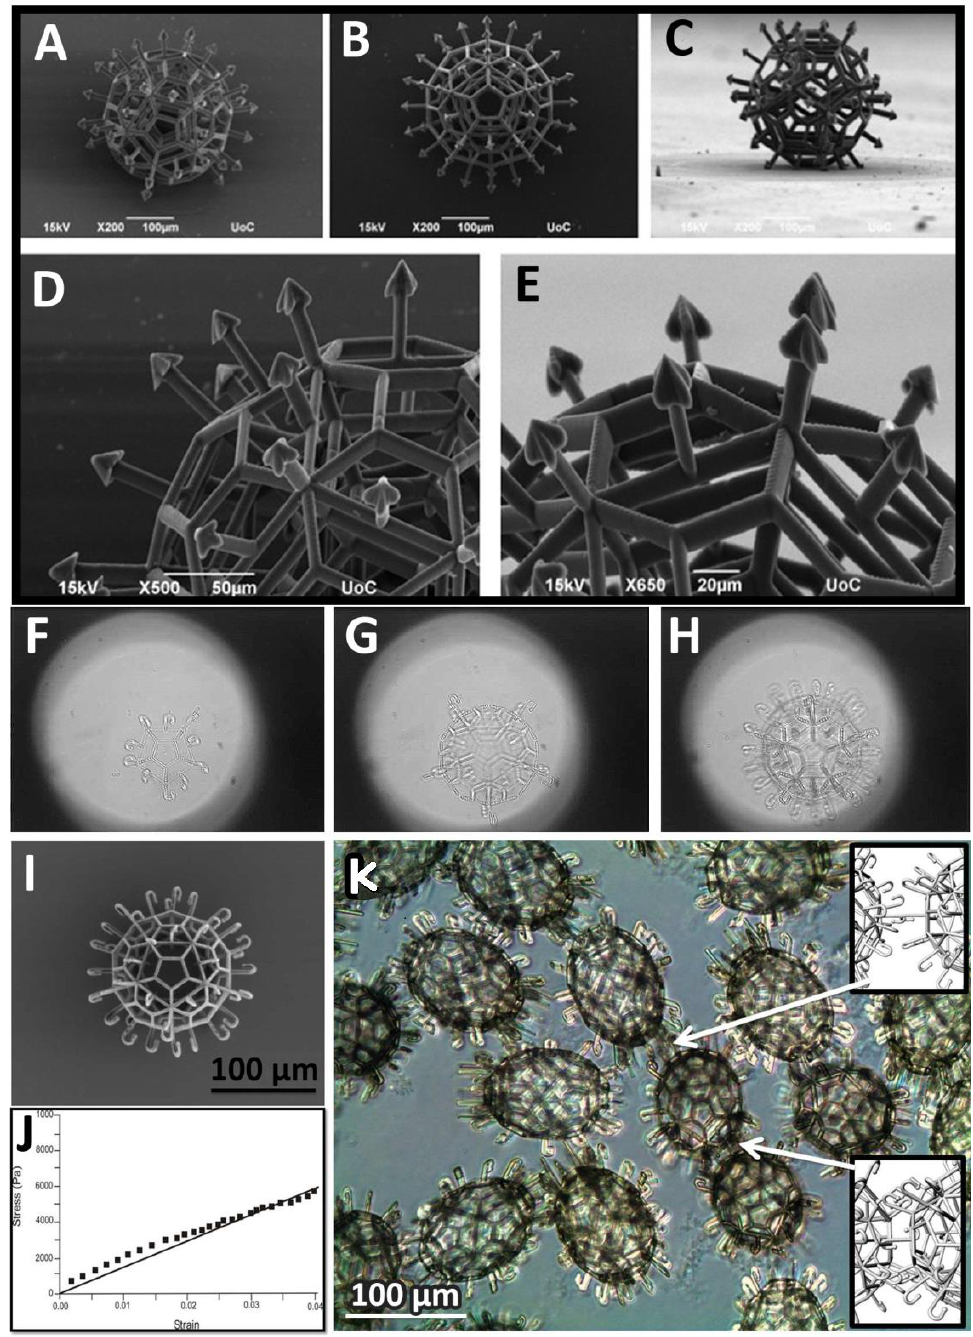
Figure 1. Design, fabrication by two-photon polymerization, sequential material characterization, and estimation of interlockability of mini-scaffolds (“lockyballs”). ( A – E ) SEM of arrow-headed “lockyballs” (Reprinted with permission from [8]. Copyright [2015], American Vacuum Society); ( F – H ) sequential steps of layer-by-layer fabrication of “lockyballs”; ( I ) SEM of “lockyball”; ( J ) material properties of “lockyballs”—stress-strain curve; ( K ) interlocking mechanism of “lockyballs” ( F – K reprinted from